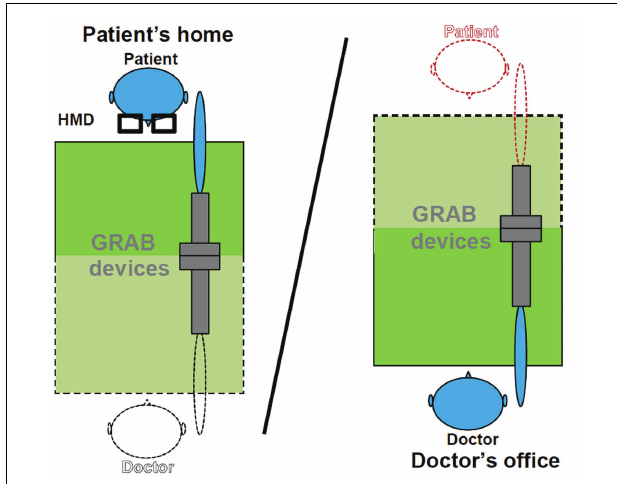
FIGURE 2 | Haptic interaction set-up in the mixed mode. Objects displayed with black dot lines represent virtual objects seen through the HMD by the patient; objects drawn with continuous lines represent local objects at the corresponding side.